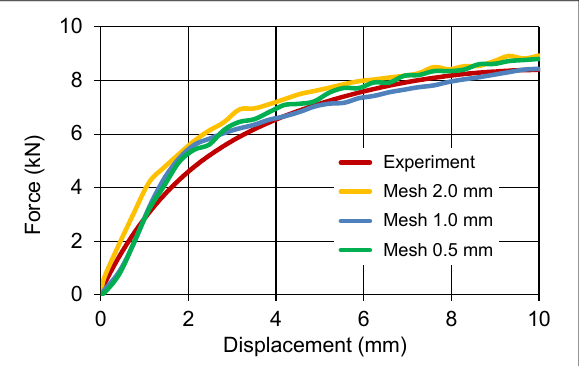
Figure 7. Force–deflection diagram for the 2nd bending test at different mesh sizes (MJC model).